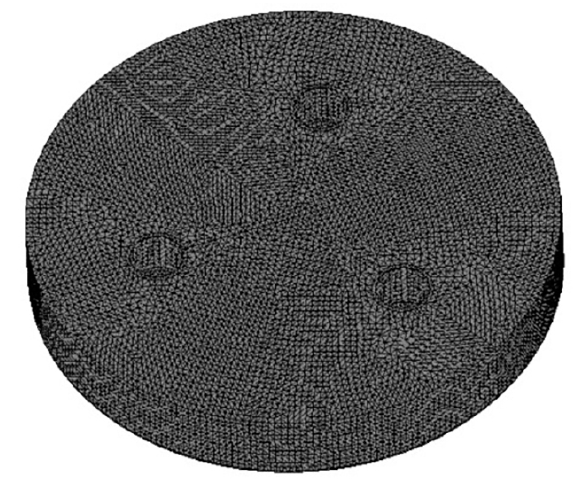
Figure 5. Finite-element model of mirror structure.